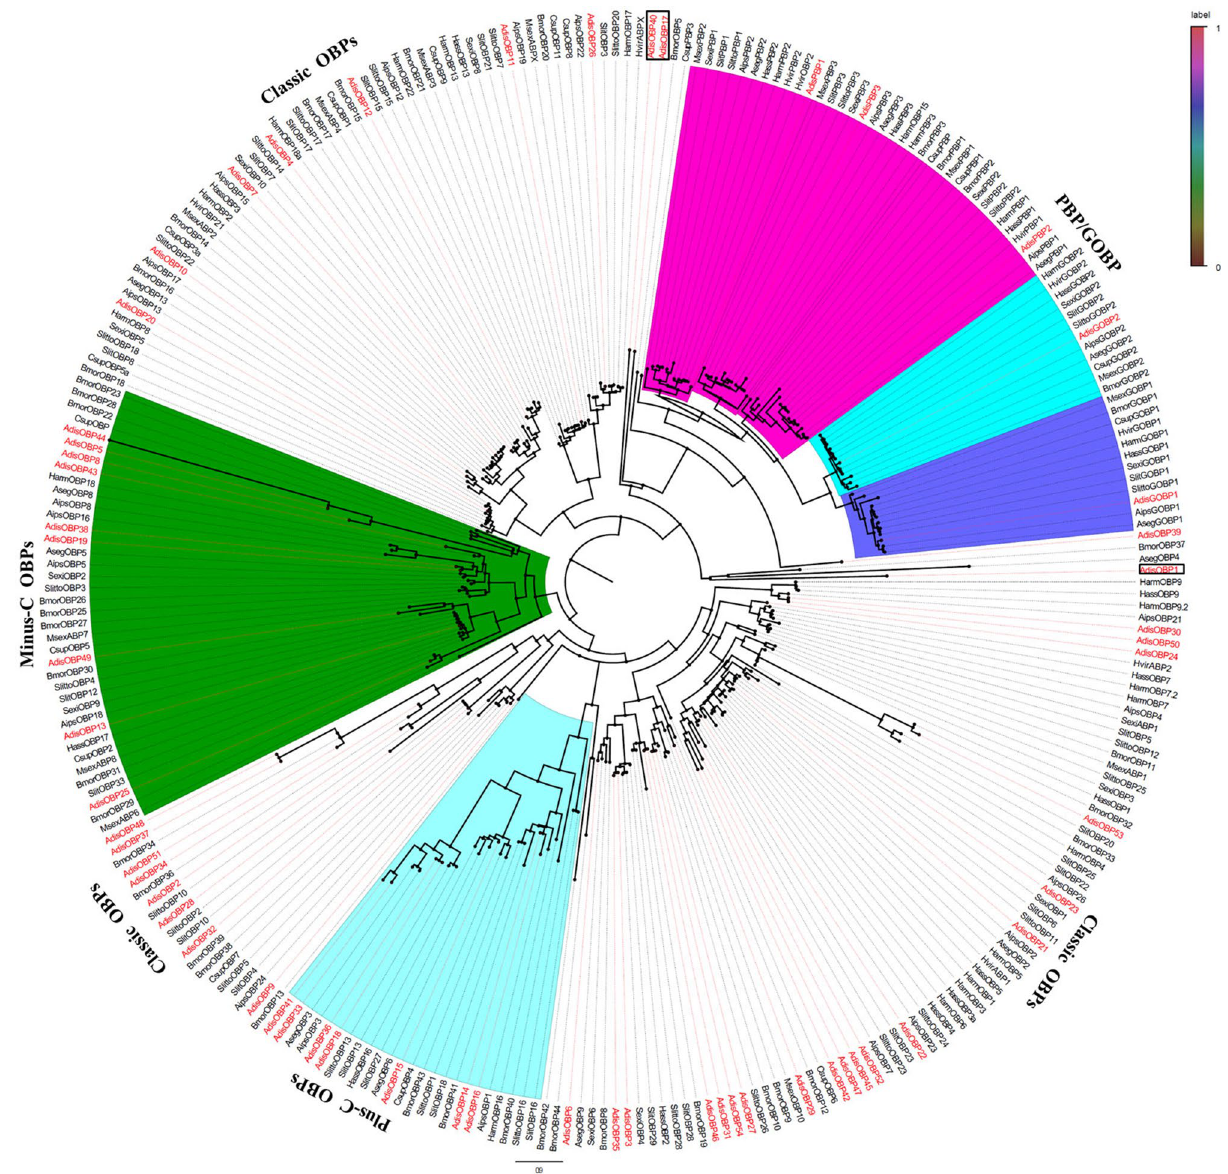
Figure 4. Phylogenetic relationships of candidate OBP proteins (including 5 OBPs identified in a previous study) from Athetis dissimilis and 33 Lepidoptera